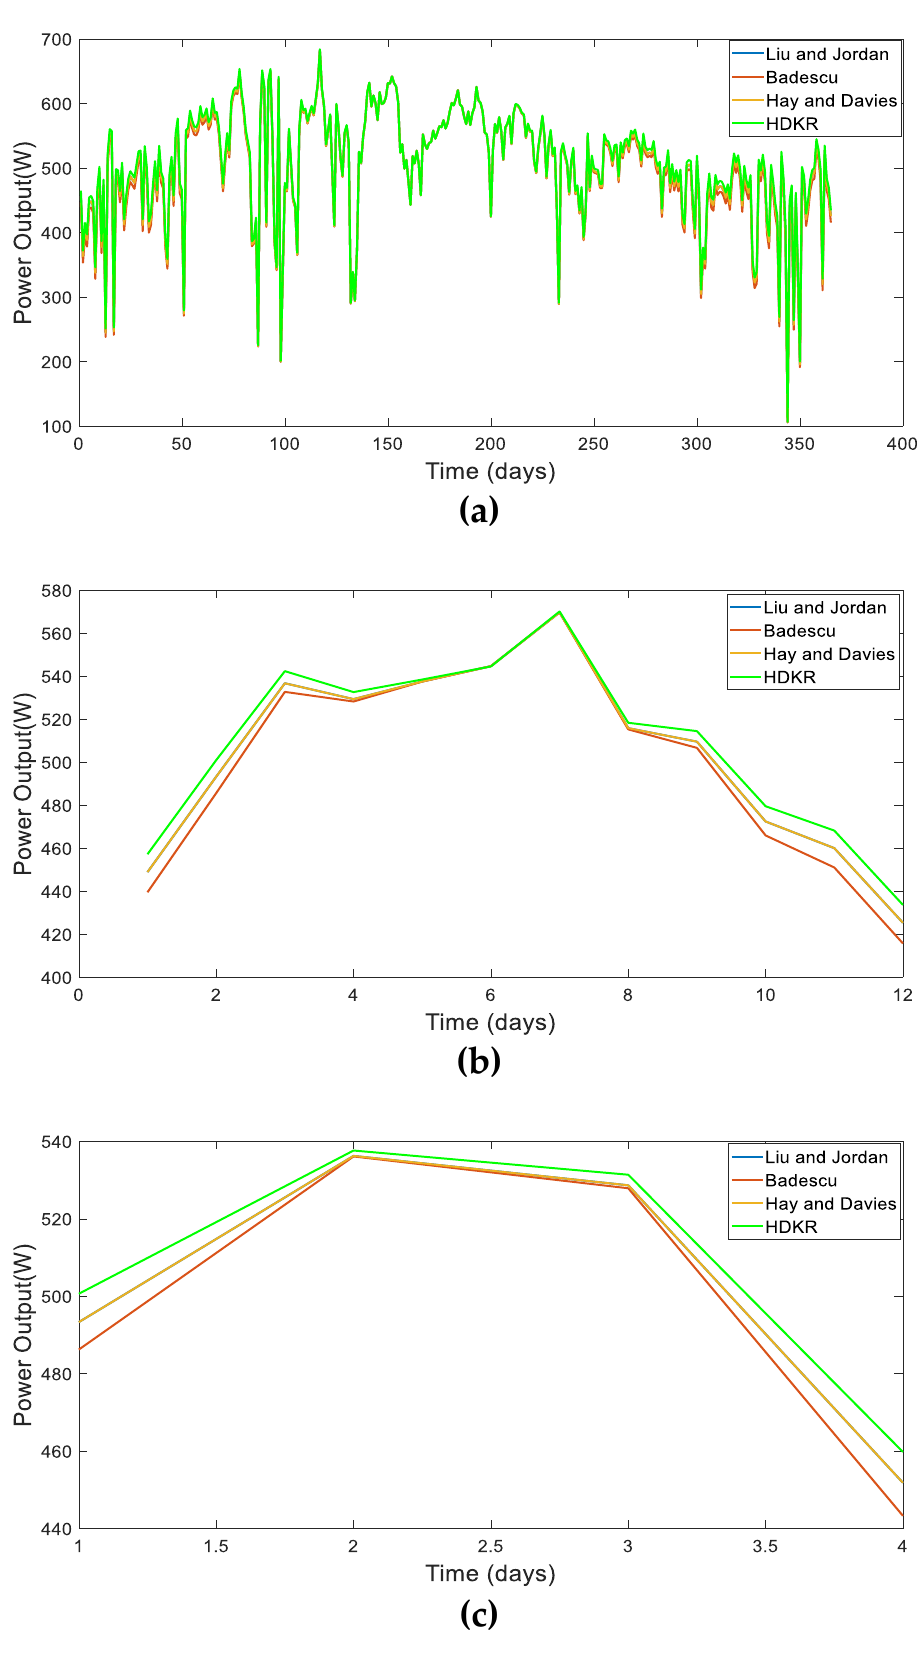
Figure 10. PV power output comparison between different models in Makkah city for different periods: ( a ) NP = 365; ( b ) NP = 12; ( c ) NP = 4.